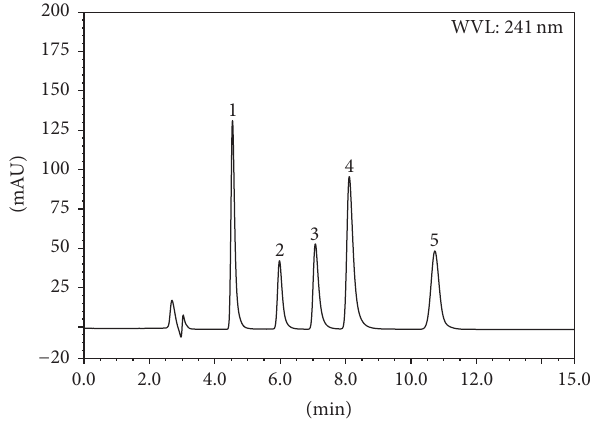
Figure 2: HPLC chromatograms of AZA (1), GRA (2), TRO (3), OND (4), and DEX